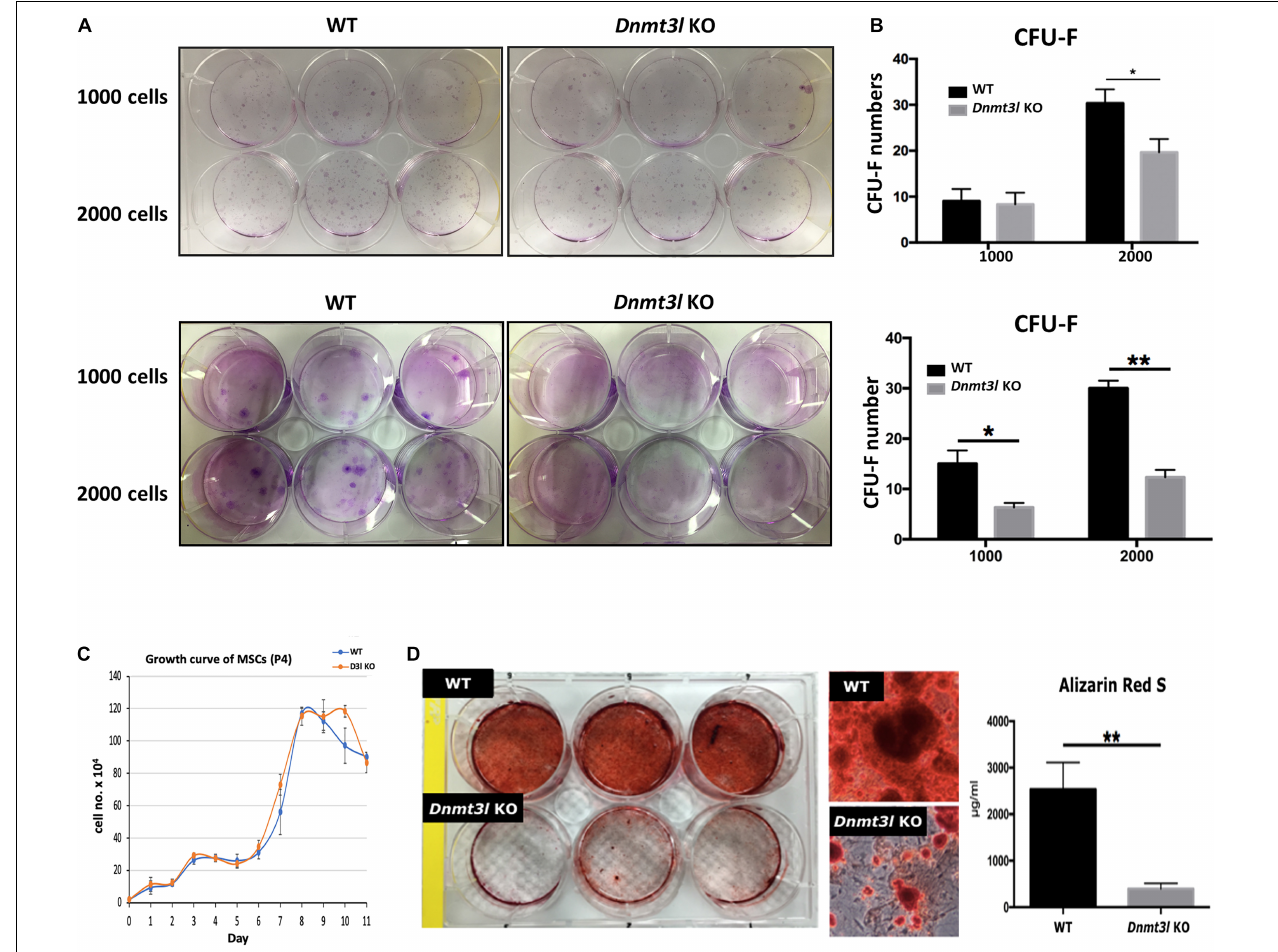
FIGURE 1 | Dnmt3l KO BM-MSCs have significantly reduced CFU-F forming rate and impaired osteogenic potential. (A) Dnmt3l KO and wild type MSCs at passage 4 were seeded at 1000 cells per well or 2000 cells per well density on 6-well plate, and calculate the colony forming unit-fibroblasts (CFU-F) number after 9 days of culture. Two batches of independent studies with mixed BM-MSCs from three mice of each genotype were shown. (B) The bar chart shows CFU-F from WT and Dnmt3l KO mice. The CFU-F with diameter greater than 2 mm were considered valid. (C) MSCs expanded from passage 3 to 4 were seeded at a density of 2 × 10 4 cells per well in 12 well plates. Cells from three wells of each genotype were isolated each day for 11 days and were calculated for live cell numbers based on trypan blue dye exclusion. (D) MSCs expanded from passage 3 to 4 were seeded at 5 × 10 4 cells per cm 2 for each well in 6-well plates. Cells were cultured in osteogenic induction medium once confluence was reached. After 14 days of osteogenic induction, calcium precipitation was quantified by alizarin red S staining. The osteogenic ability was dramatically decreased in MSCs derived from Dnmt3l KO mice compared to that in MSCs obtained from their wild-type littermates. The data are presented as the means ± SEM. * p < 0.05, ** p <